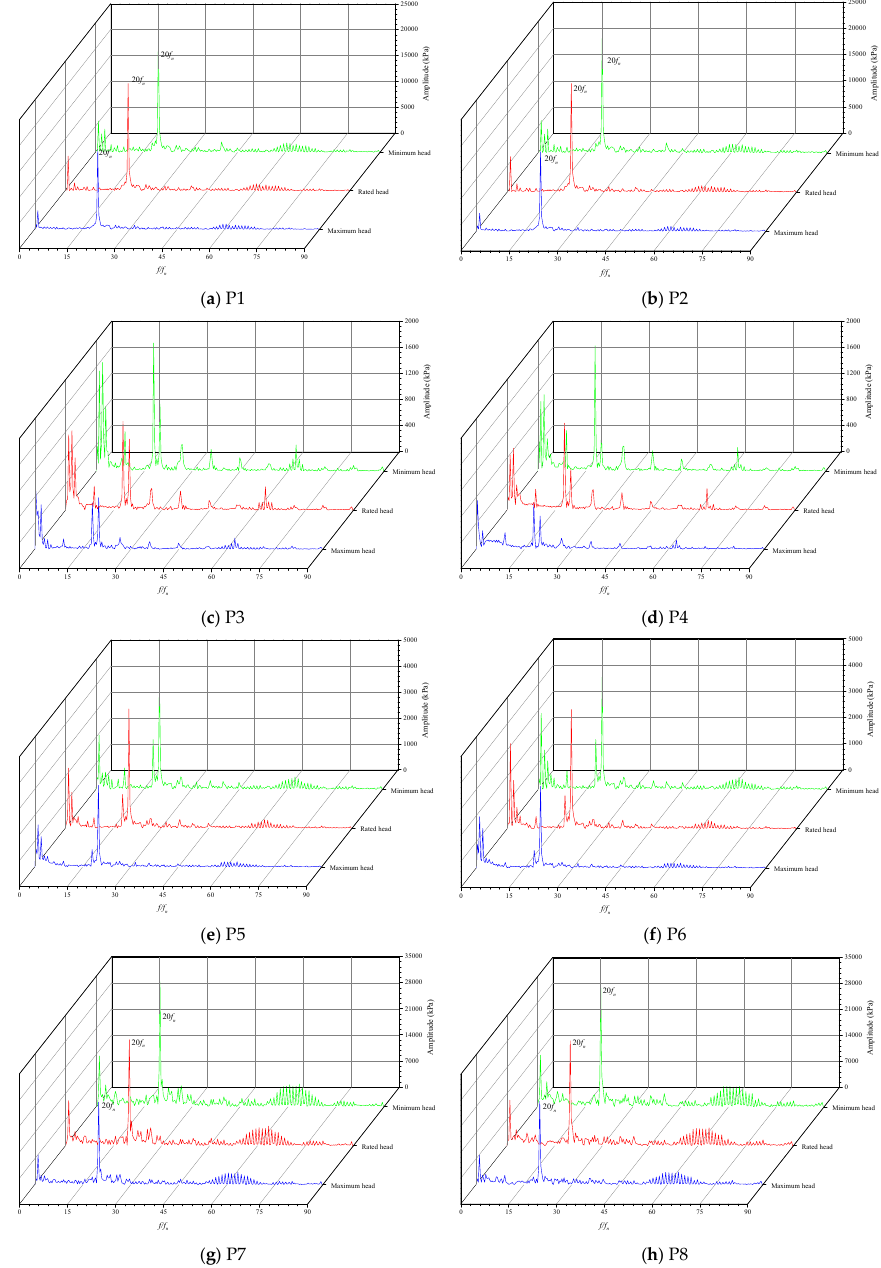
Figure 8. Frequency spectra of the pressure pulsation at monitoring